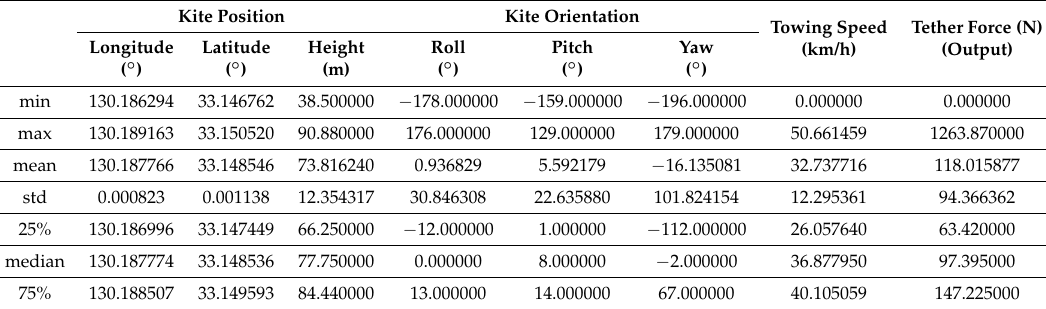
Table 1. Data from sensors and statistics of the numerical